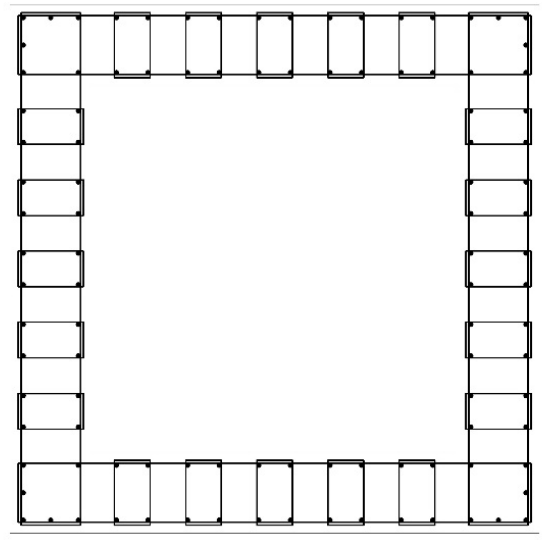
Figure 6. Typical cross section of the column.